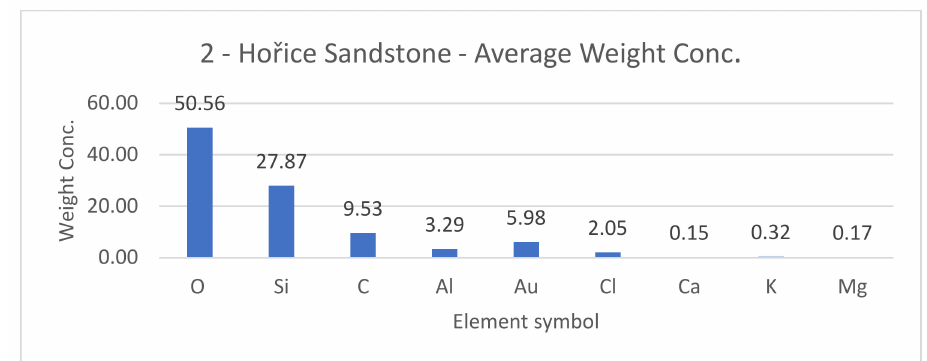
Figure 13. Hoˇrice sandstone average weight concentration